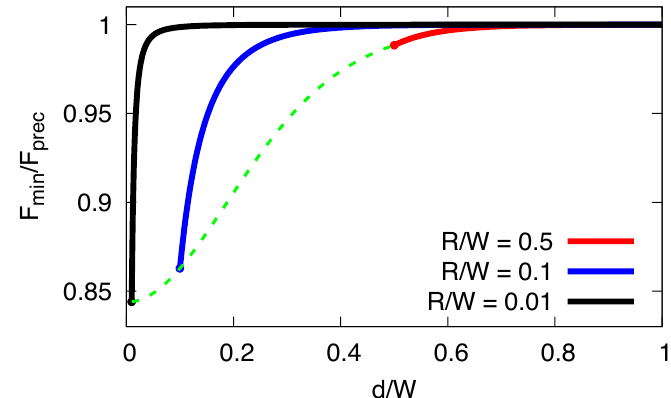
Figure 6. Total elastic energy for a precipitate as function of scaled distance d / W from an originally straight grain boundary ( W is the lateral distance in an array of precipitates) for ν = 1/4. For large distances, the grain boundary does not affect the energy, and it approaches the value F min = F prec . For lower distances, the energy is reduced and leads to an effective attractive interaction towards the grain boundary and a lower solubility limit. The curves end at the point when the precipitates touch the grain boundary ( d = R ), and a penetration raises the energy again (not shown; see [14] for a discussion). The limit d = R is shown as the dashed curve for arbitrary ratio d / W .